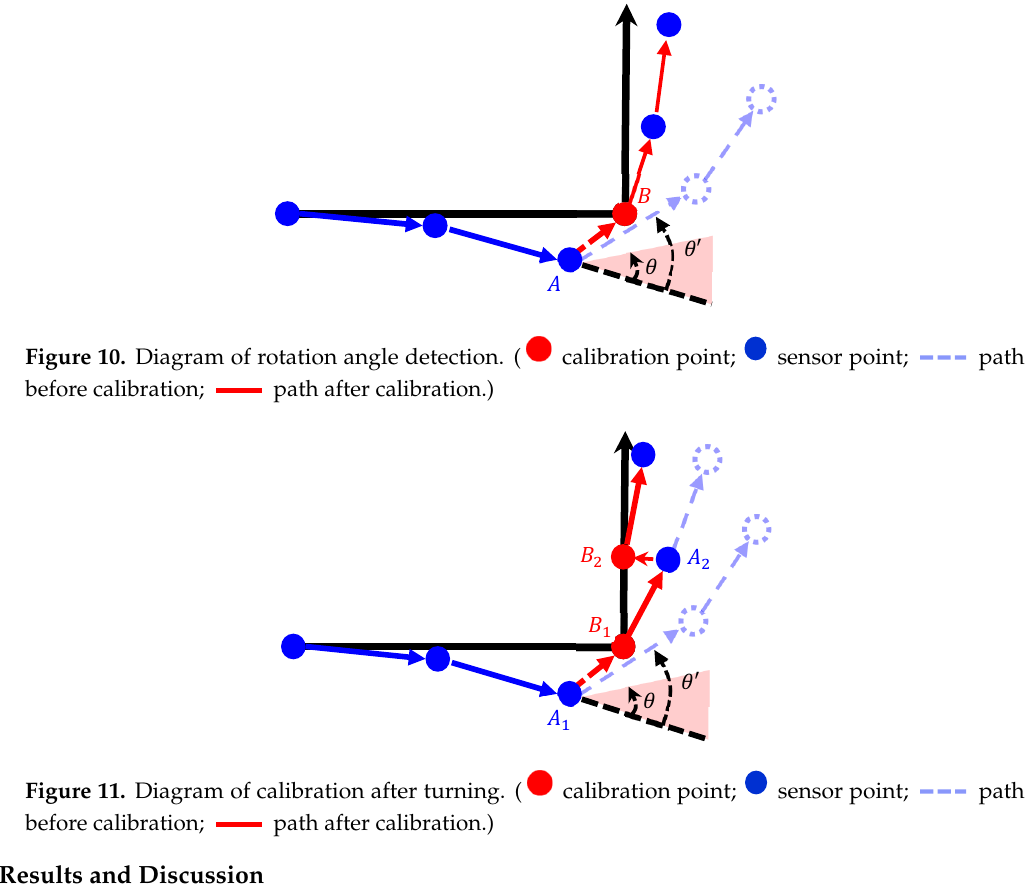
Table 3. Basic Attributes of the Fields.